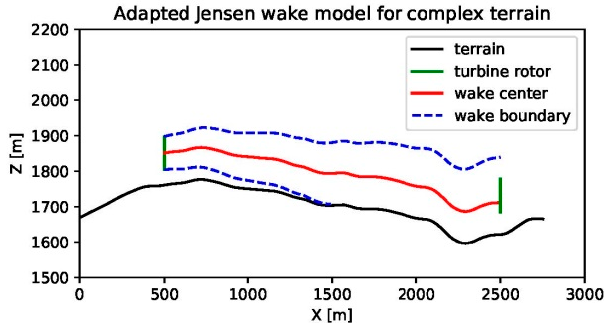
Figure 2. Schematic of the adapted Jensen wake model for a wind turbine in complex terrain.